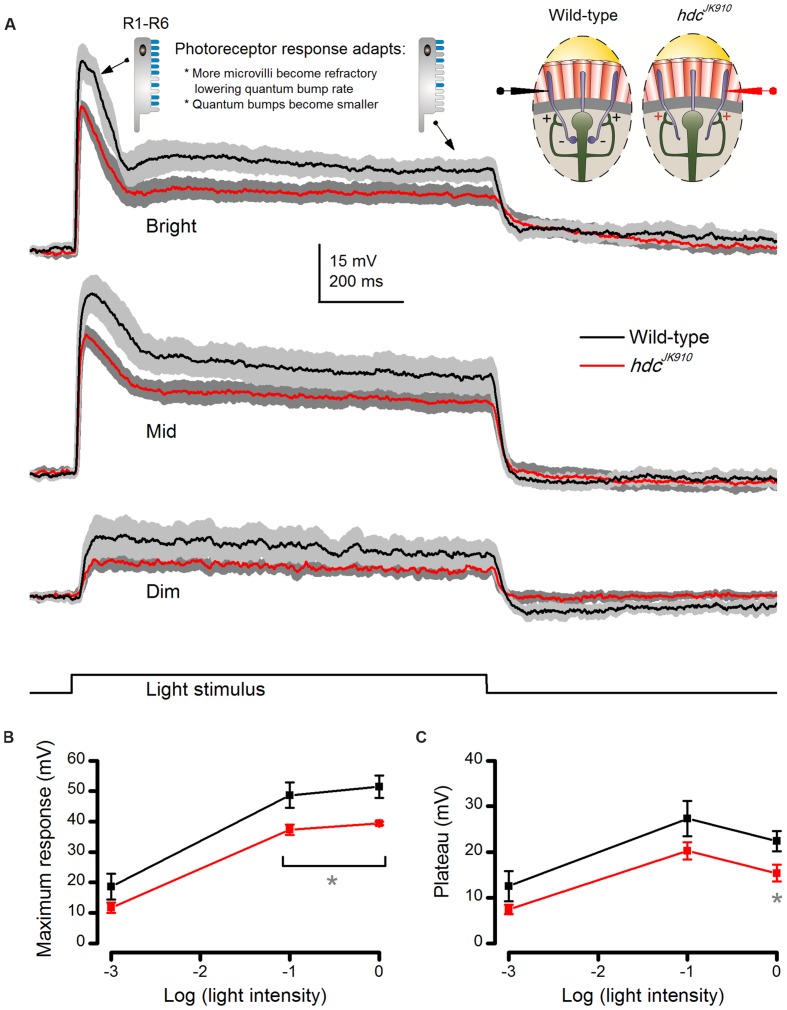
hdcJK910 photoreceptors’ voltage responses to long (1 s) light pulses are smaller than those of the wild-type.
(A) On average, hdcJK910 photoreceptors produced smaller responses than the wild-type to long light pulses of all tested intensities, but their responses adapted similarly. The underlying sampling dynamics are described in the main text. (B) Their maximum amplitudes differed significantly to Bright and Mid pulses. Dim: Maxwild-type = 18.62 ± 4.28 mV, Maxhdc = 11.74 ± 1.69 mV, p = 0.194. Mid: Maxwild-type = 48.60 ± 4.14 mV, Maxhdc = 37.23 ± 1.70 mV, p = 0.049. Bright: Maxwild-type = 51.35 ± 3.64 mV, Maxhdc = 39.35 ± 0.57 mV, p = 0.029. (C) Their plateau voltage differed significantly only in experiments with Bright light pulses. Dim: Pwild-type = 12.51 ± 3.29 mV, Phdc = 7.44 ± 1.04 mV, p = 0.204. Mid: Pwild-type = 27.28 ± 3.86 mV, Phdc = 20.24 ± 1.87 mV, p = 0.154. Bright: Pwild-type = 22.36 ± 2.23 mV, Phdc = 15.37 ± 1.82 mV, p = 0.043. (A–C): nwild-type = 5, nhdc = 5; Mean ± SEM, two-tailed t-test. All recordings performed at t = 19°C.